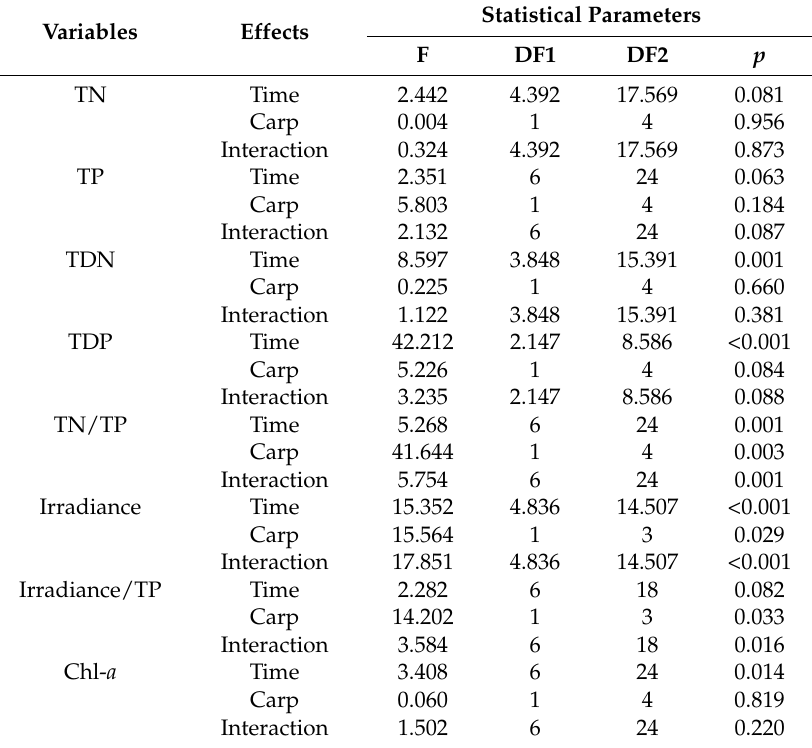
Table 1. Detailed information on rmANOVA results on the effects of crucian carp (Carp) on total (TN, TP) and dissolved (TDN, TDP) nutrients, TN/TP ratios, irradiance, irradiance to total phosphorus ratios (Irradiance/TP), and chlorophyll a (Chl- a ) concentrations during the experiment